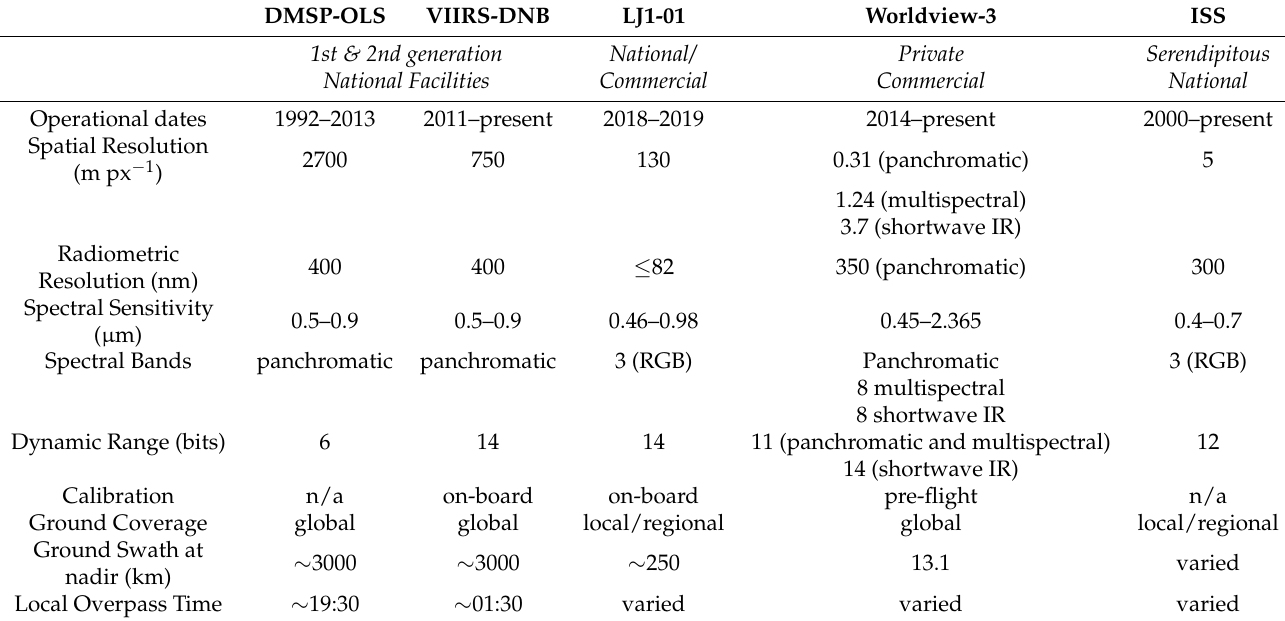
Table 1. Specifications of selected night-lights orbital sensing